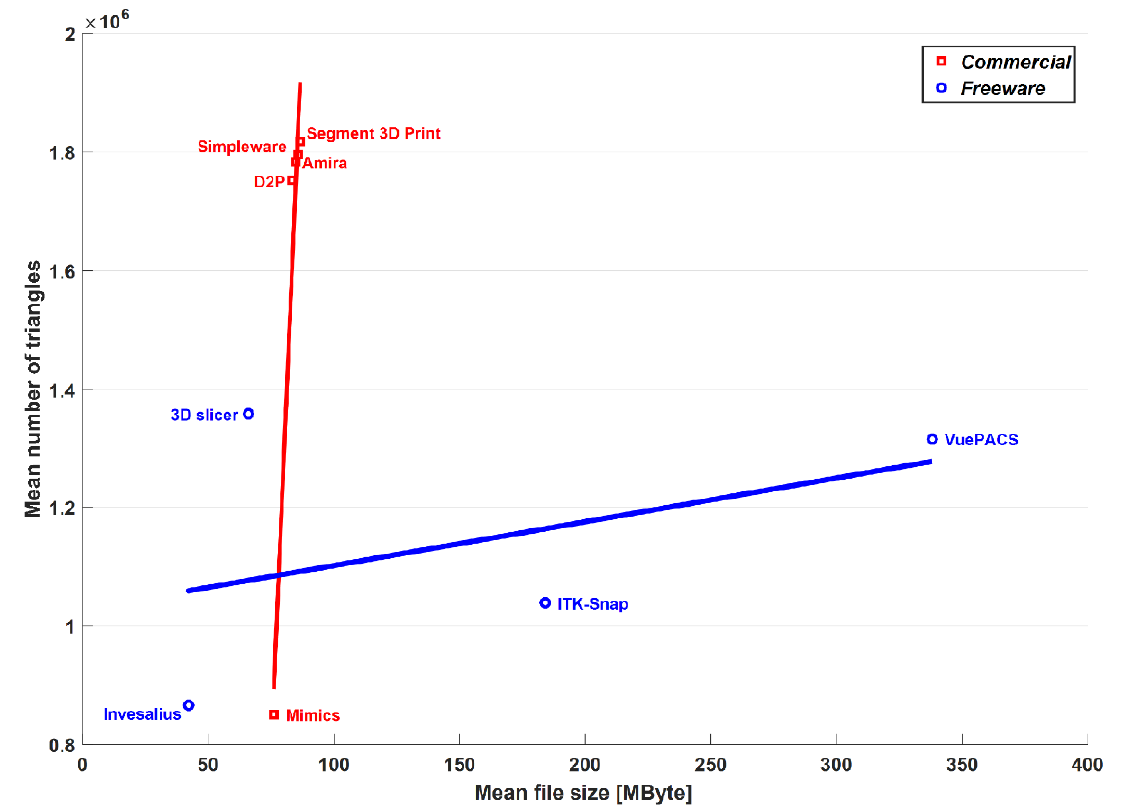
Figure 3. Graphical representation in terms of mean number of triangles and mean file size of the output meshes over the 15 anatomical models. Results obtained in the present study with commercial software are superimposed to the corresponding results previously obtained by these authors with freeware software on the same models [25]. Corresponding linear regression lines are superimposed for comparison.